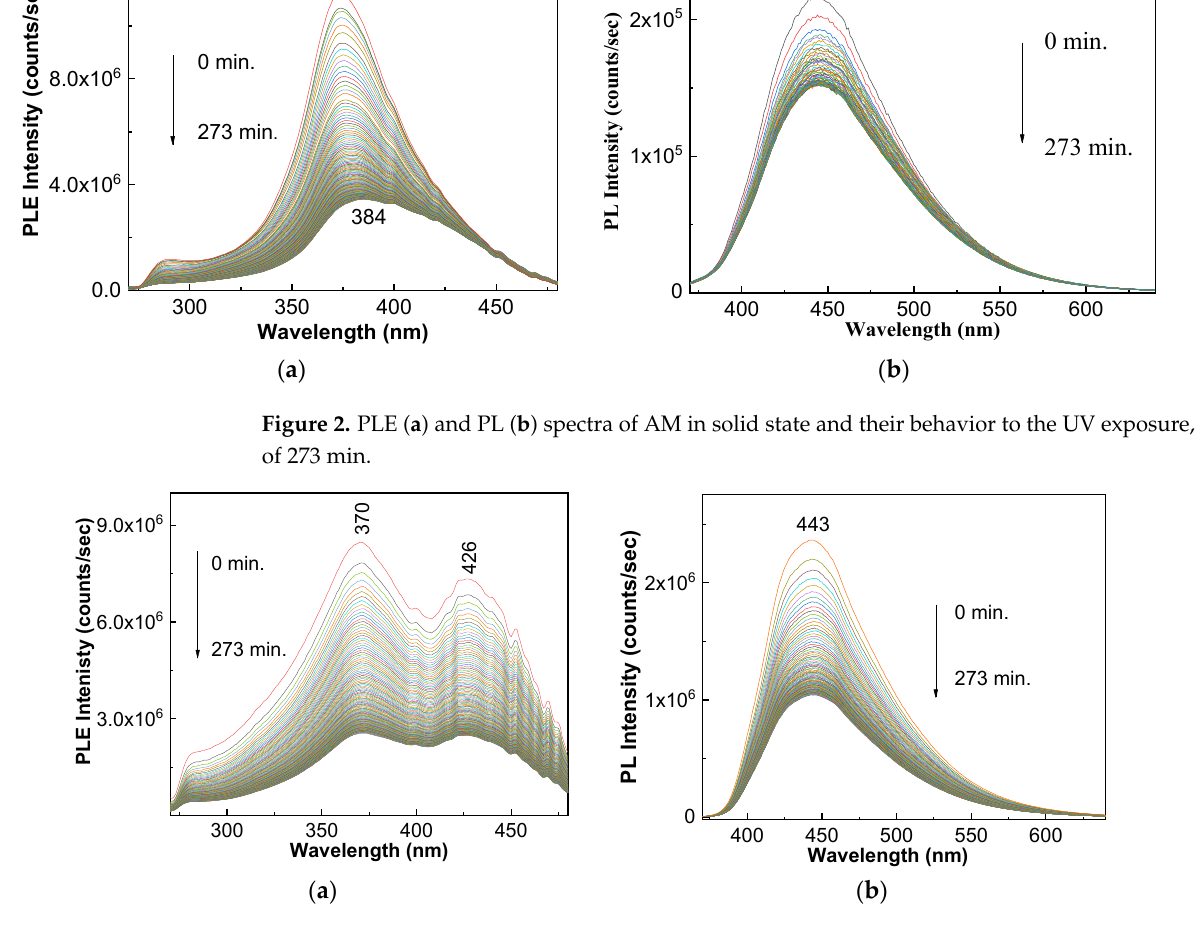
Figure 3. PLE ( a ) and PL ( b ) spectra of the AMP drug and their behavior to the UV exposure, time of 273 min.